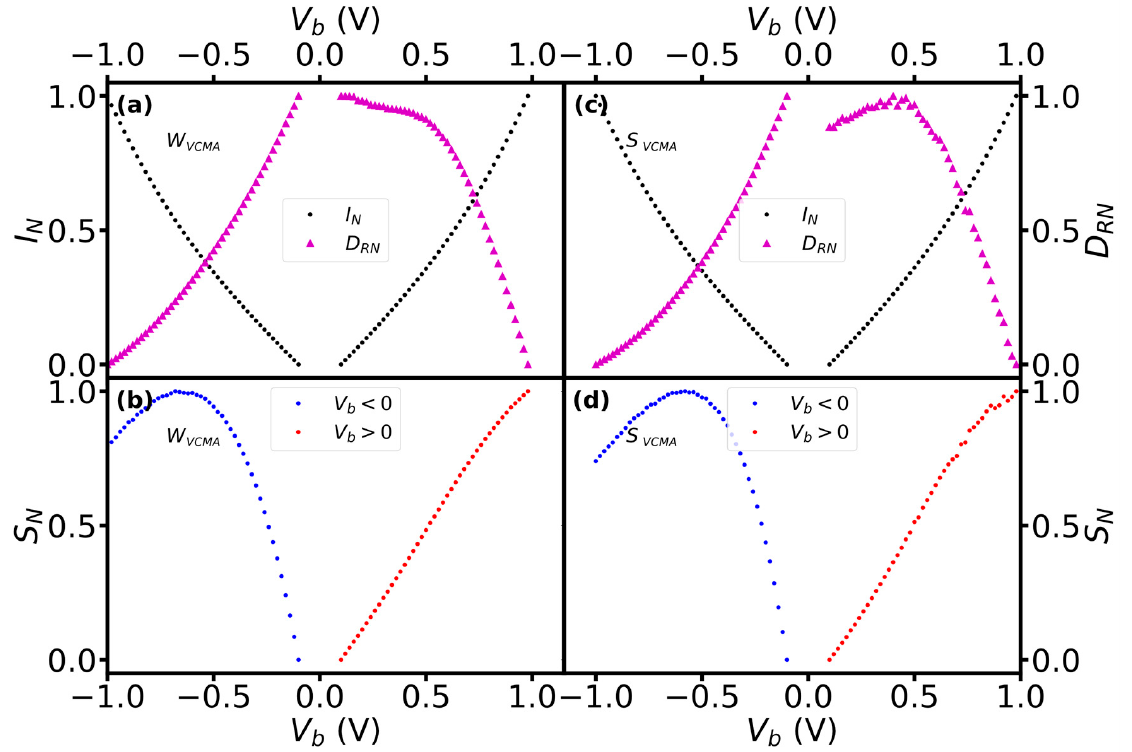
Figure 8. The normalized dependence of current, derivative of R-H and sensitivity on bias voltage for sensors with weak ( a , b ) and strong ( c , d ) VCMA modifications.